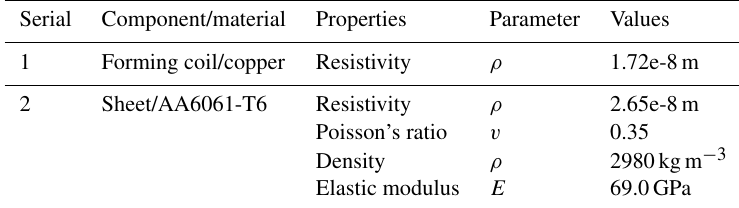
Table 1. Electrical and mechanical properties of the sheet and coil (Cui et al., 2014).